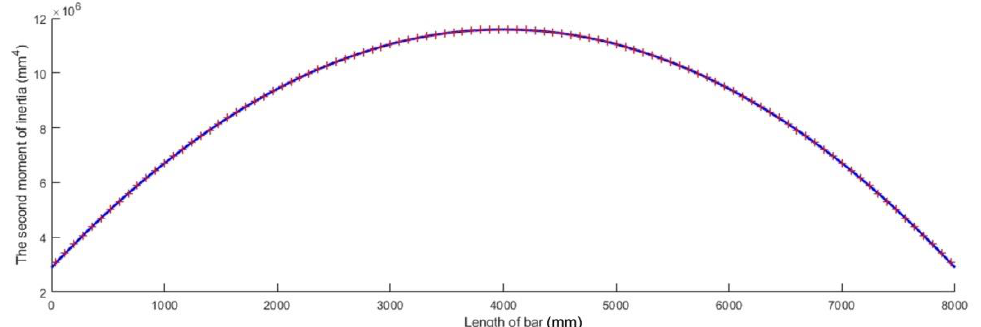
Figure 5. Parabolic variation in the second moment of inertia I along the bar axis.